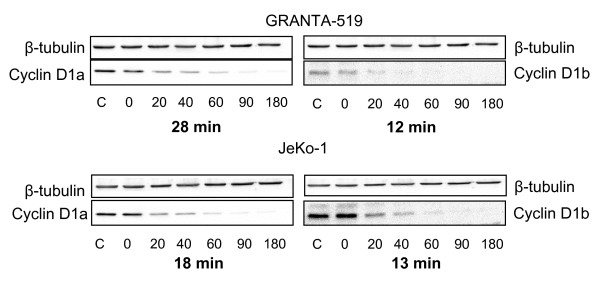
Stability of cyclin D1a and cyclin D1b isoforms. GRANTA-519 and JeKo-1 cells were untreated (C) or treated with cycloheximide (50 μg/ml final concentration) for 3 h. Cells were harvested 20–180 min later and total proteins were extracted and analyzed as described before. A densitometric analysis was performed to quantify proteins level and to estimate proteins half-life. Half-lives are indicated under the blots.